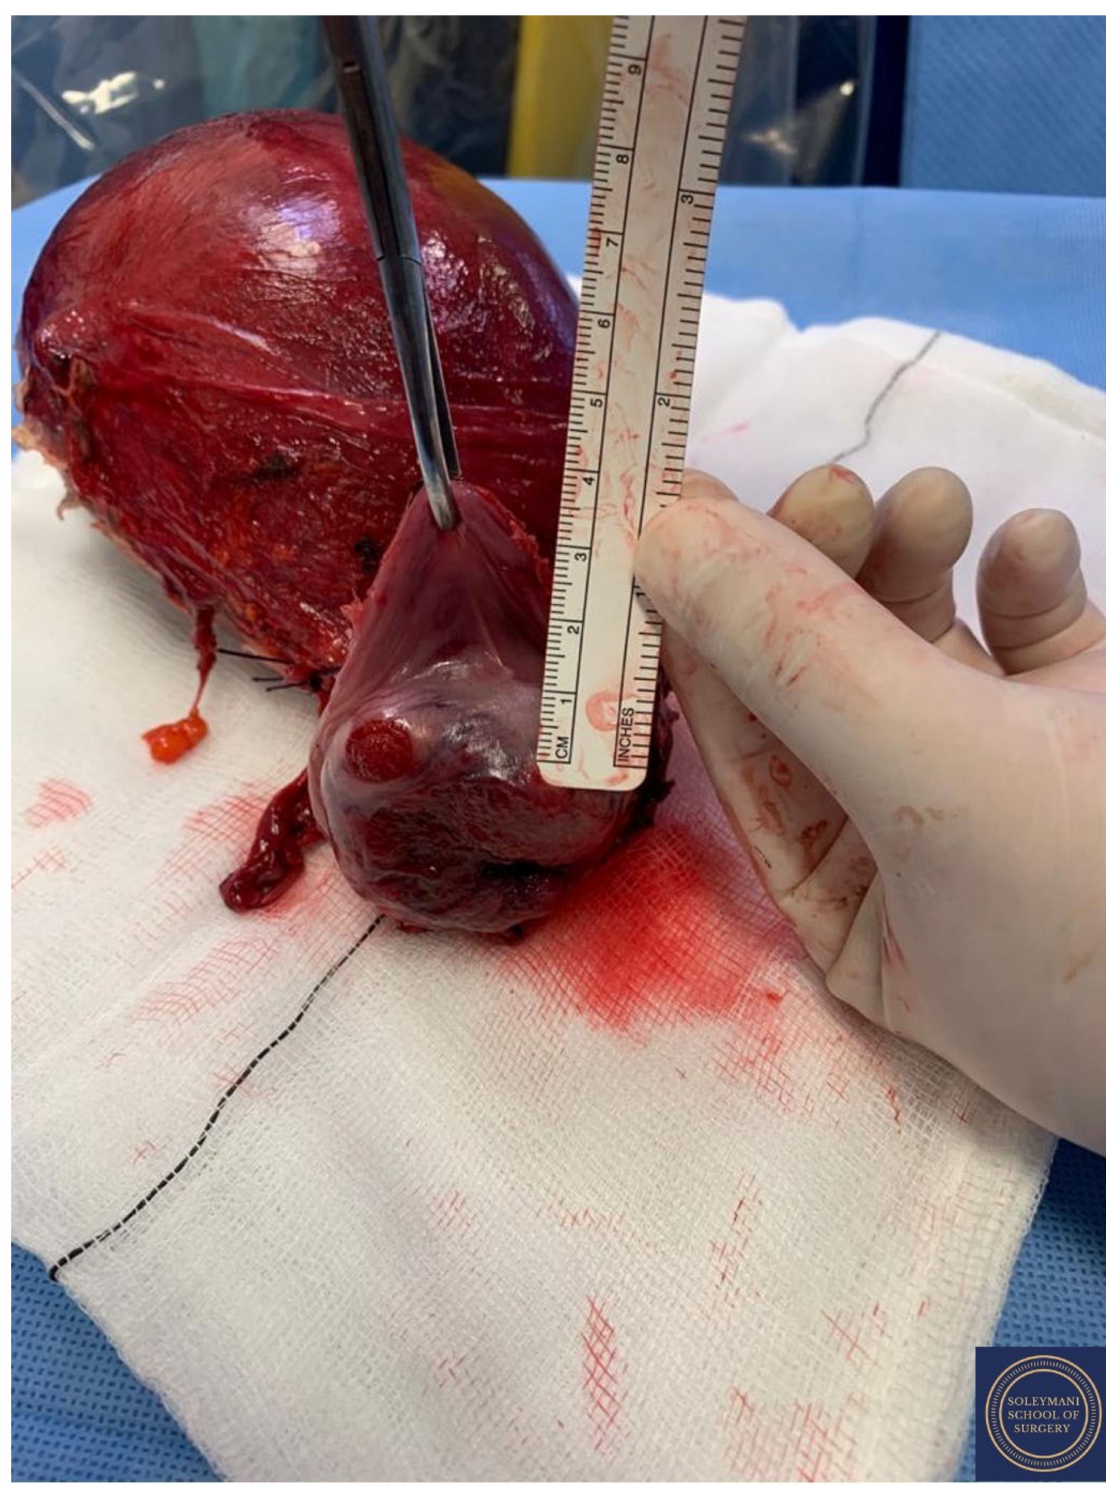
Figure 16. Appearance of the vaginal cuff on the final